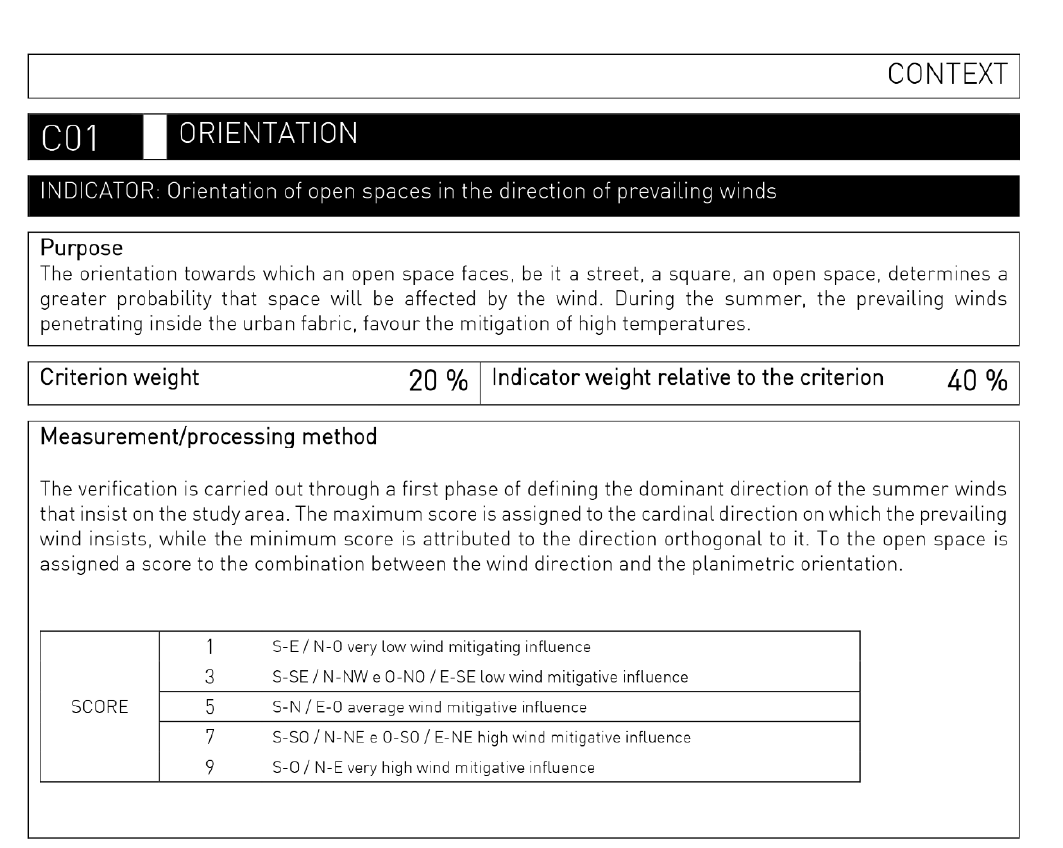
Figure A7. Descriptive sheet of the indicator of “Orientation”.